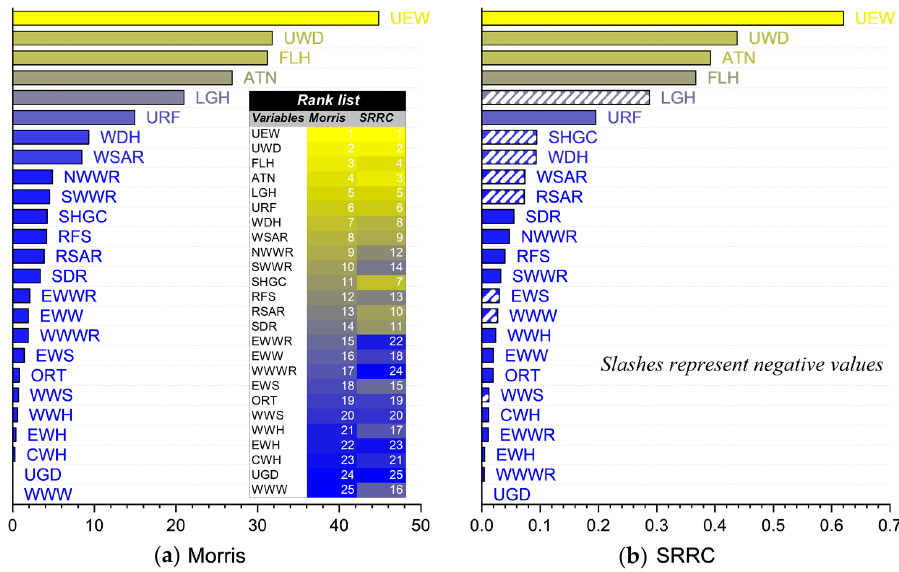
Figure 7. Ranking of sensitivity parameters to heating demand obtained by the two methods in the first-stage SA: ( a ) SRRC; ( b ) Morris.